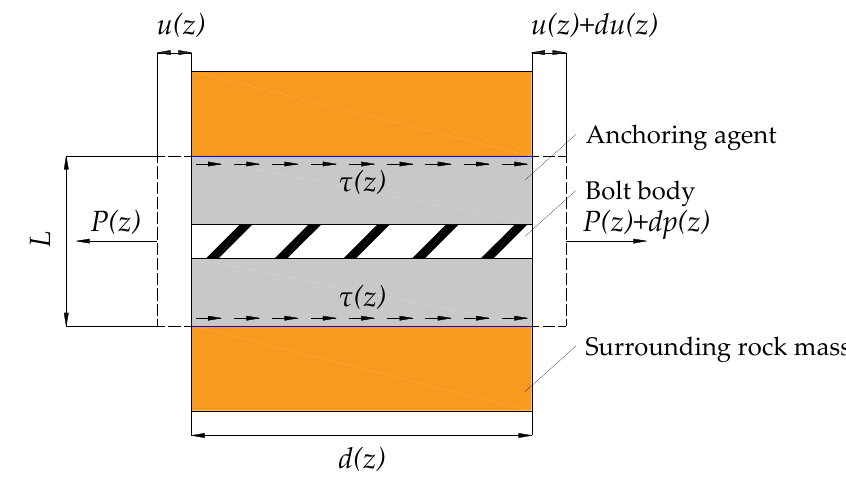
Figure 3. Force of the micro-element in the anchoring section.